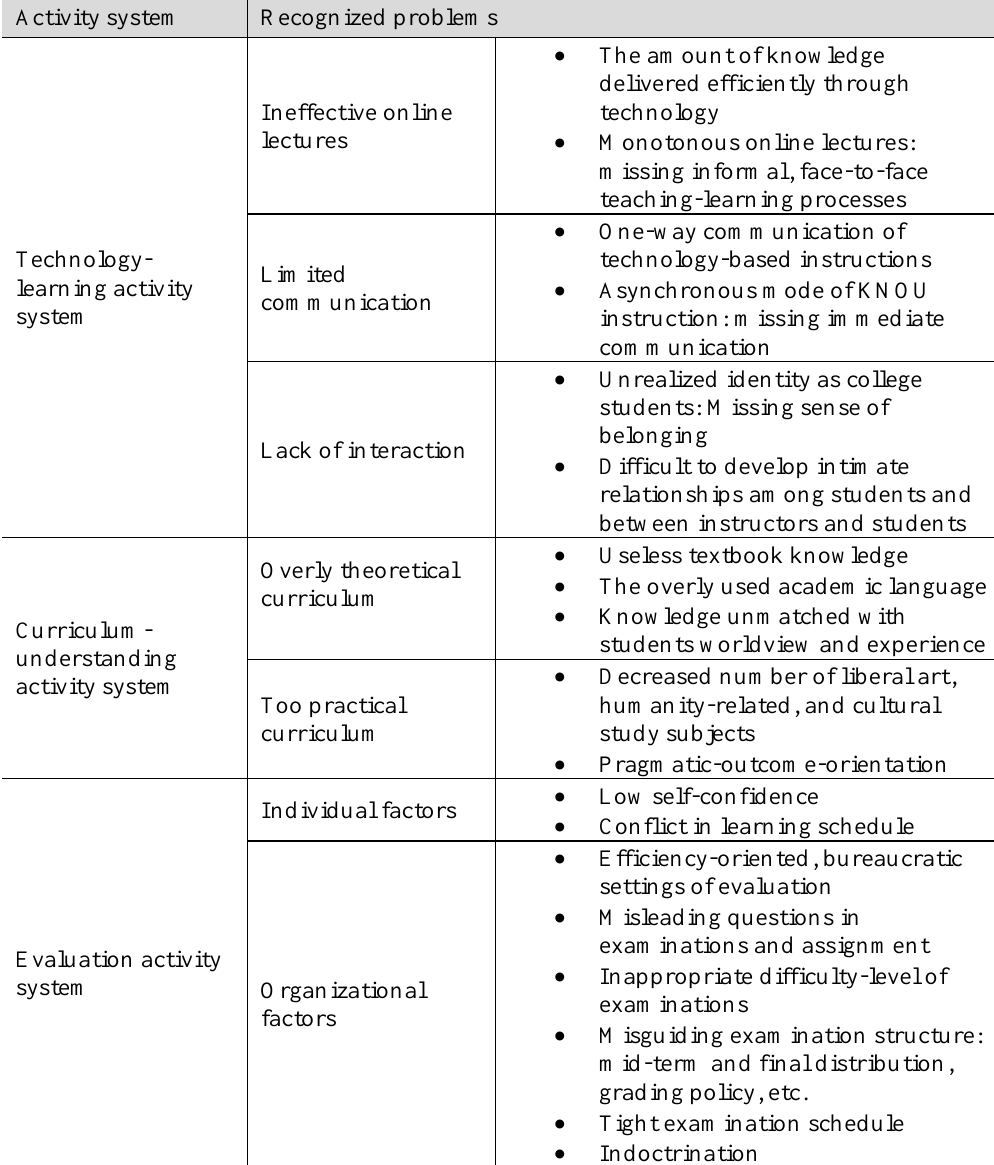
Table 1 Problems of KNOU Education Perceived by the Participants Activity